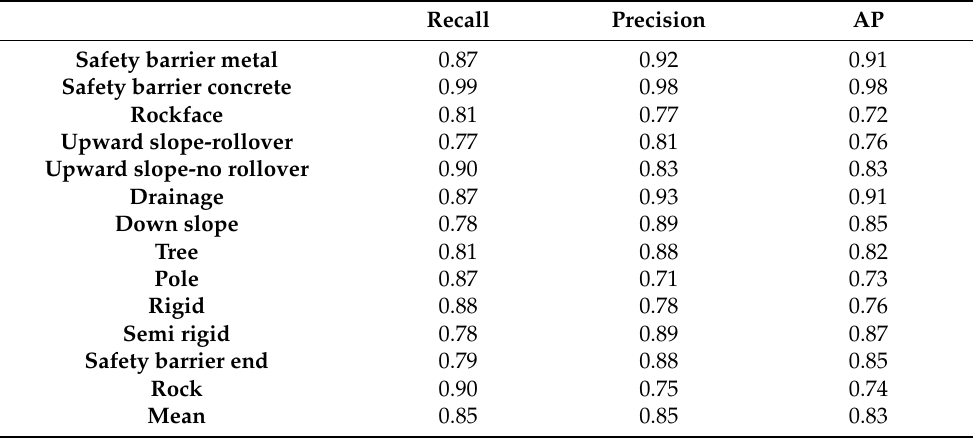
Table 3. Recall, precision, and AP for each class as well as mean recall, precision and